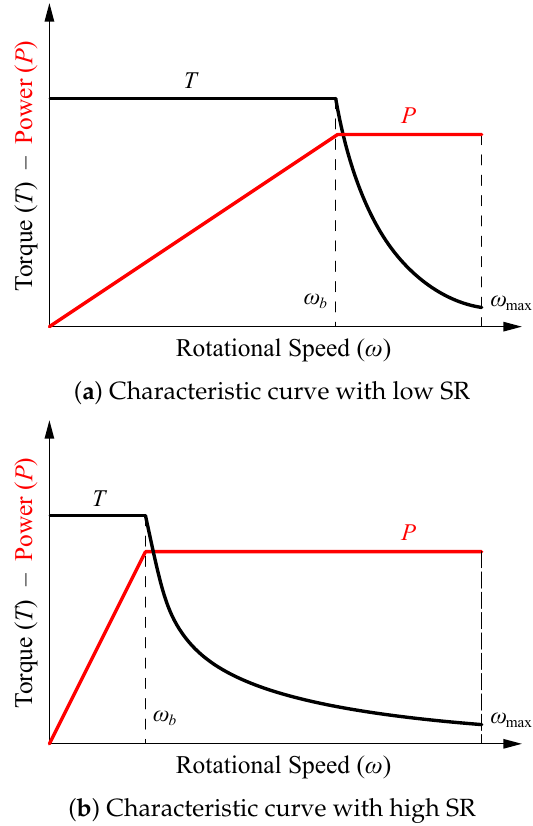
Figure 2. Comparison of characteristic